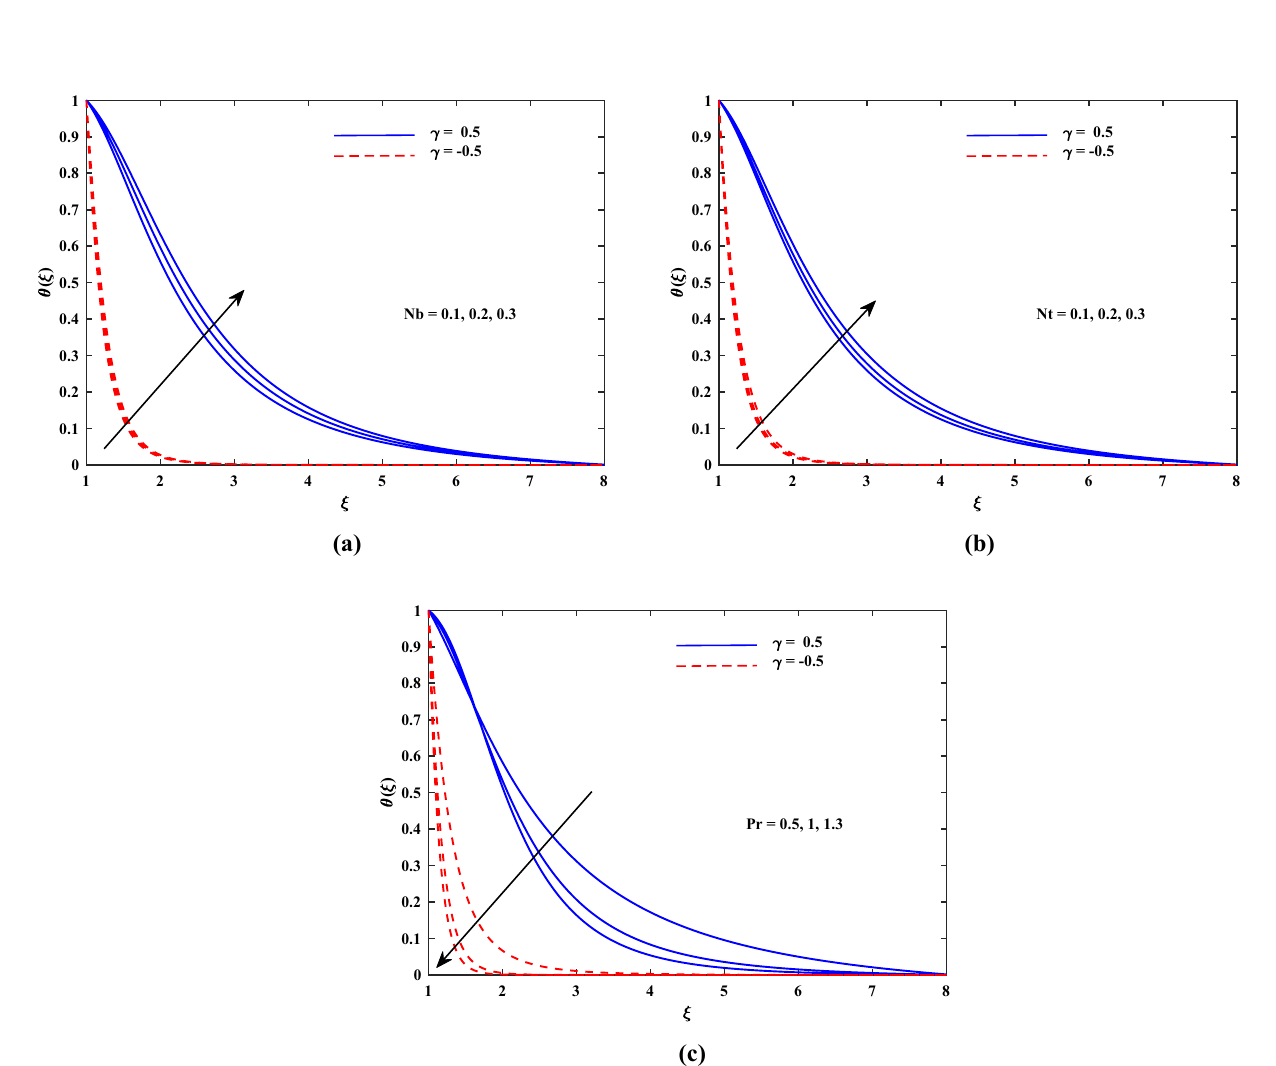
Figure 4. Plot for temperature profile θ(ξ) with varying values of Nb , Nt and Pr